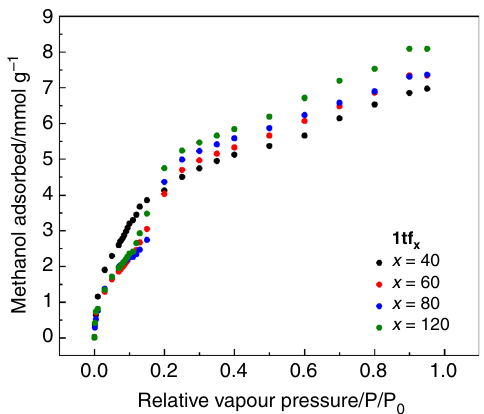
Fig. 6 Methanol adsorption isotherms of 1tf x measured at 25 °C on an environmentally controlled QCM. 1tf 40 (black plots) exhibits a single-step methanol adsorption isotherm, whereas 1tf 60 (red plots), 1tf 80 (blue plots) and 1tf 120 (green plots) show two-step adsorption. The step in the adsorption pro fi les starting at P/P 0 = 0.15 indicates the threshold pressure that initiates the methanol-dependent np -to- lp structural fl exibility. Herein,